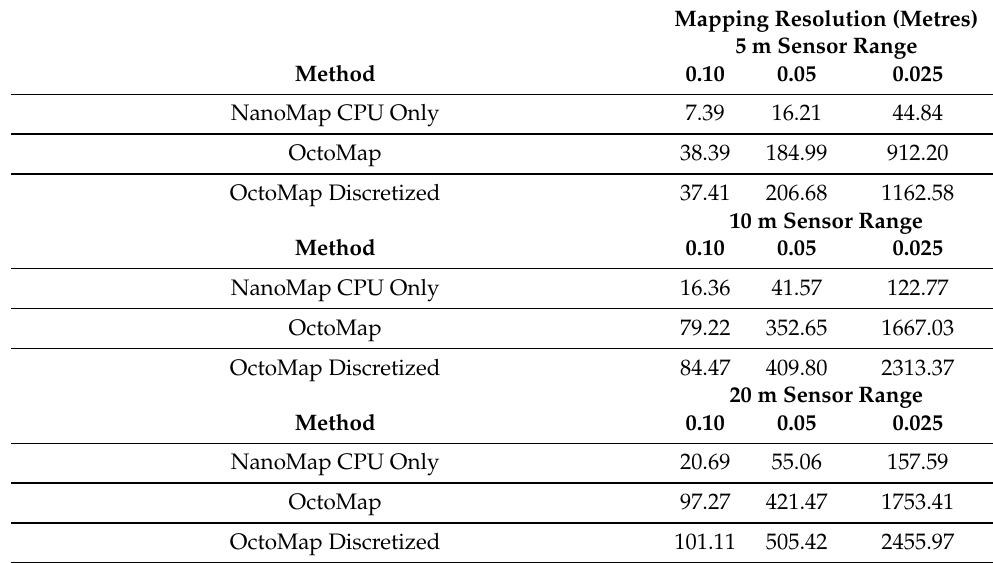
Table 6. Laser dataset average frame time for Jetson Nano (ms, lower is better).